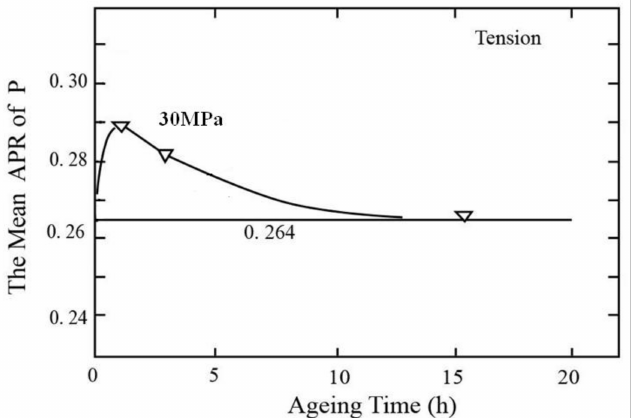
Figure 17. Changes in the mean Auger peak height ratio of phosphorus to iron (APR of P) at grain boundaries as a function of ageing time under a tensile stress for a smooth specimen of a Cr steel. Reprinted with permission from ref. [24]. Copyright 1981